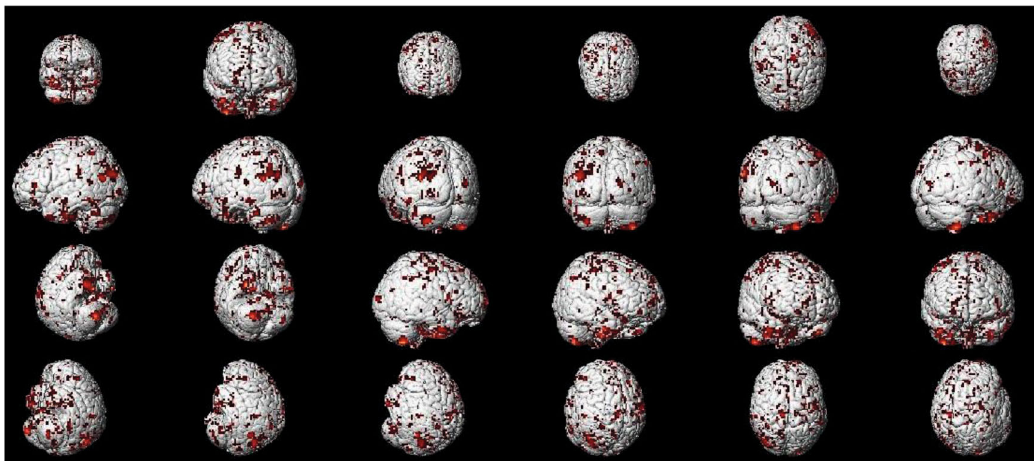
Figure 13: Regions showing signi fi cantly di ff erent EC with the rACC in placebo response compared with nocebo response